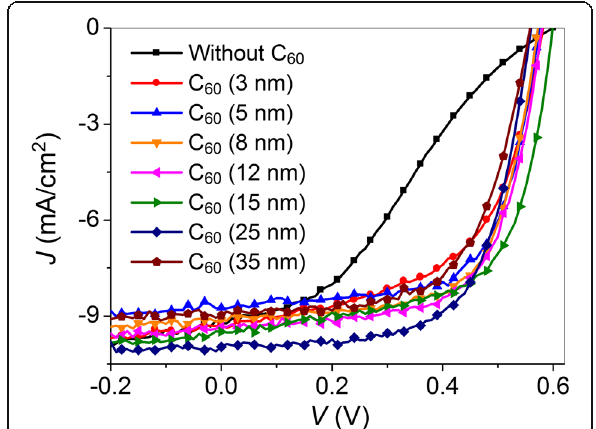
Fig. 1 J - V characteristics, recorded under 100 mW/cm 2 illumination (AM 1.5 G), of the PSCs with and without different thicknesses of C 60 inserted between P3HT:PCBM and 5-nm-thick LiF layer